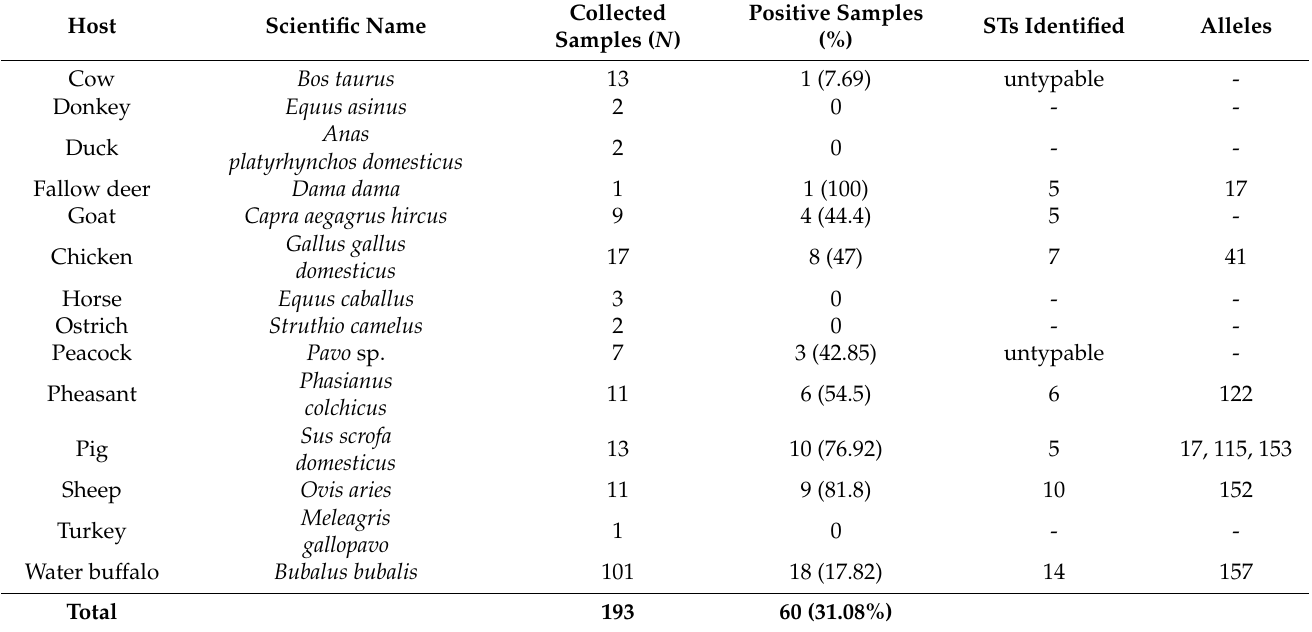
Table 1. Molecular identification and subtyping of Blastocystis collected from various animal